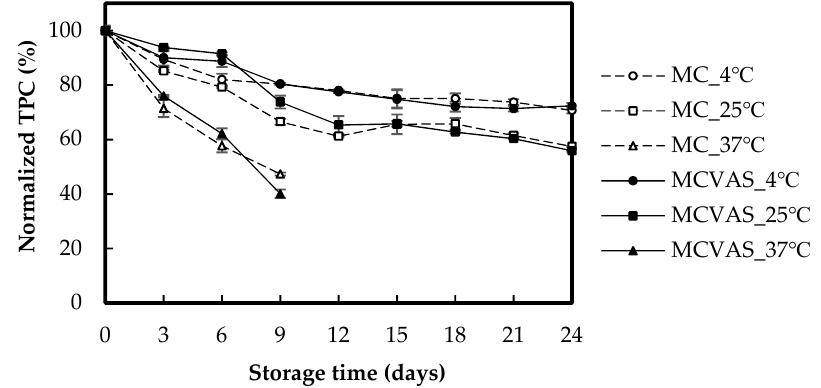
Figure 7. Effects of storage time on the normalized total phenolic content of Momordica charantia L. and Momordica charantia L. var. abbreviata Ser.